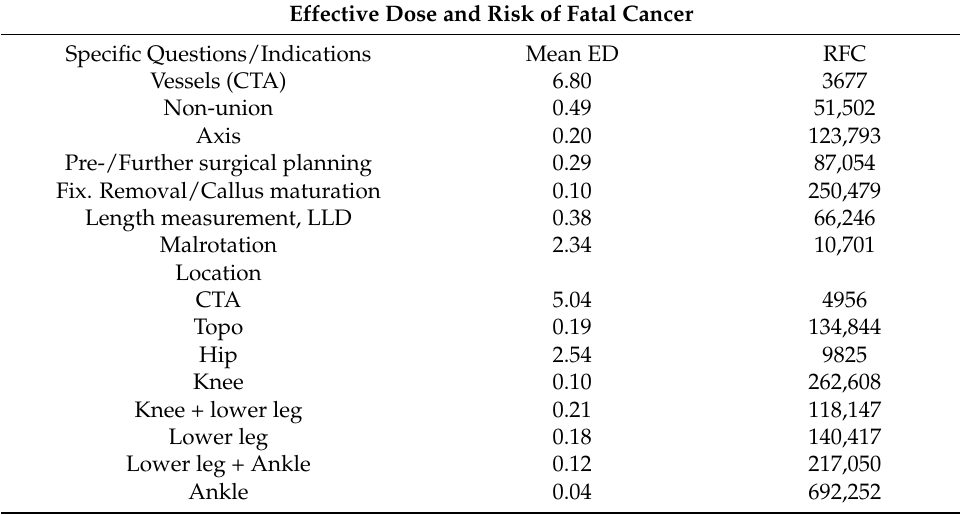
Table 5. Effective Dose (ED) and risk of fatal cancer (RFC, 1 in X) in various indications and locations for an average adult